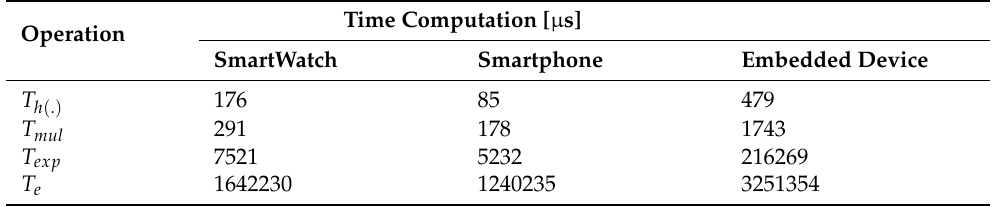
Table 3. Cryptographic Operations time in IoT